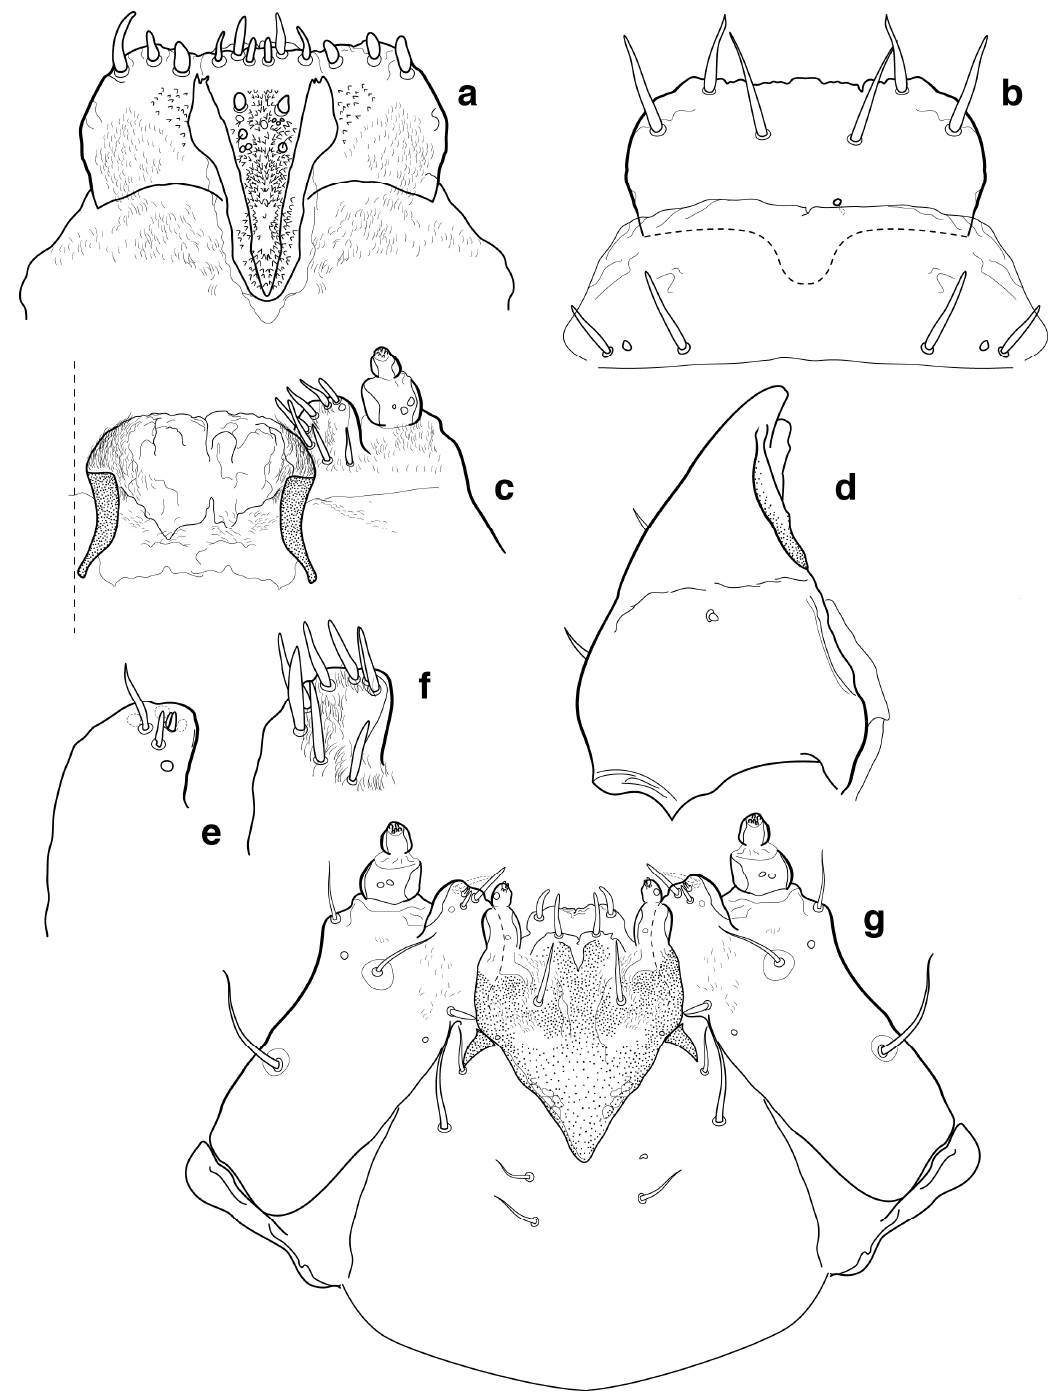
Figure 78. Rhodobaenus tredecempunctatus mouthparts: ( a ) epipharynx; ( b ) clypeus and labrum; ( c ) mala, maxillary palp, and hypopharynx, ventral view; ( d ) mandible; ( e ) detail, mala, ventral view; ( f ) detail, mala, dorsal view; and ( g ) labio-maxillary complex, ventral view.